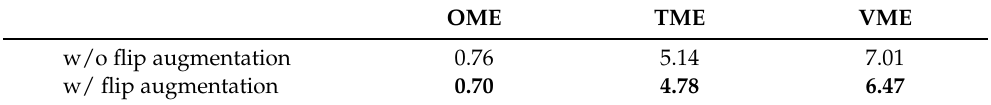
Table 6. Comparison result for flip augmentation on Human3.6M. The best results are shown in bold. OME